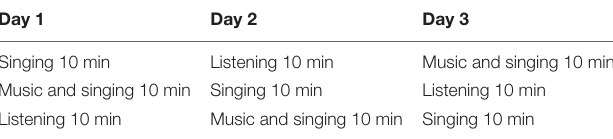
TABLE 1 | Example of intervention order given over 3